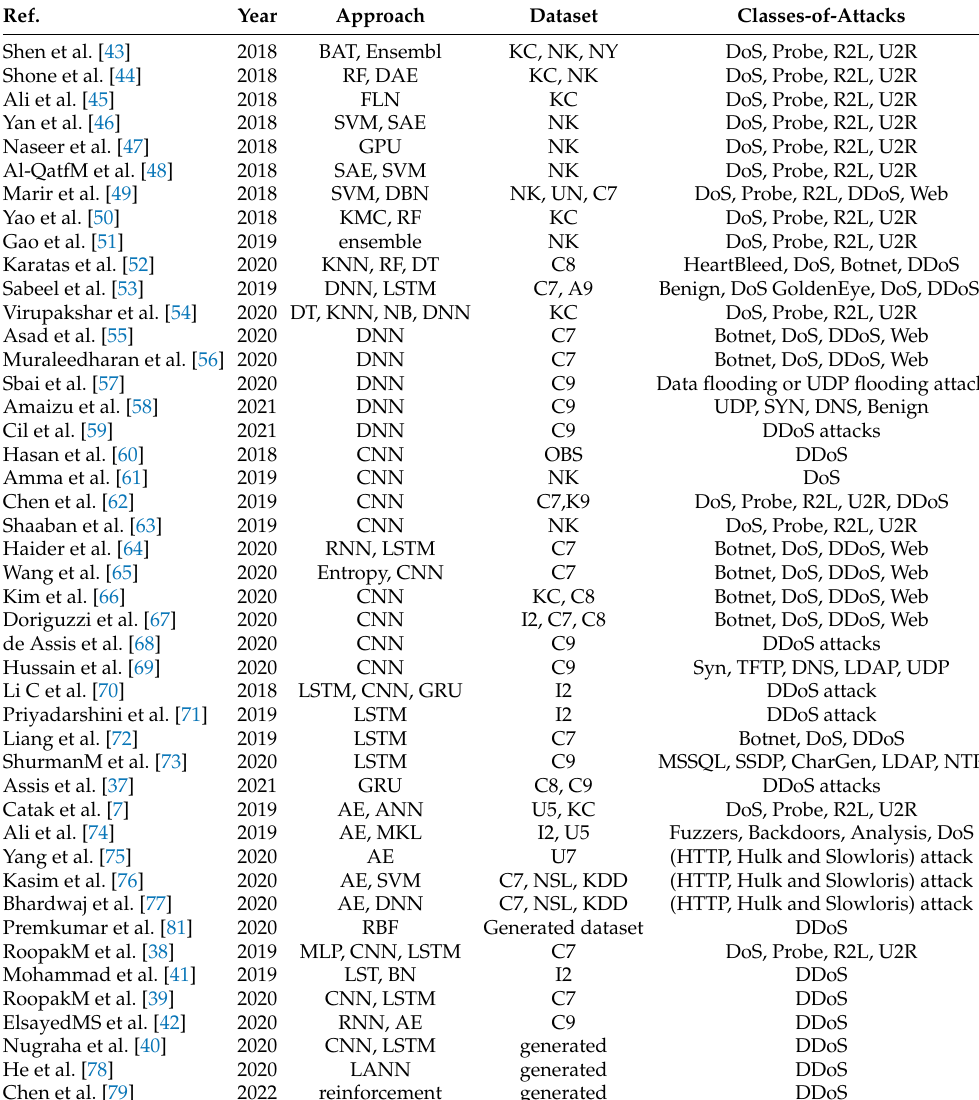
Table 4. The most current research on ML/DL for DDoS attack detection, showing techniques, datasets, and types of